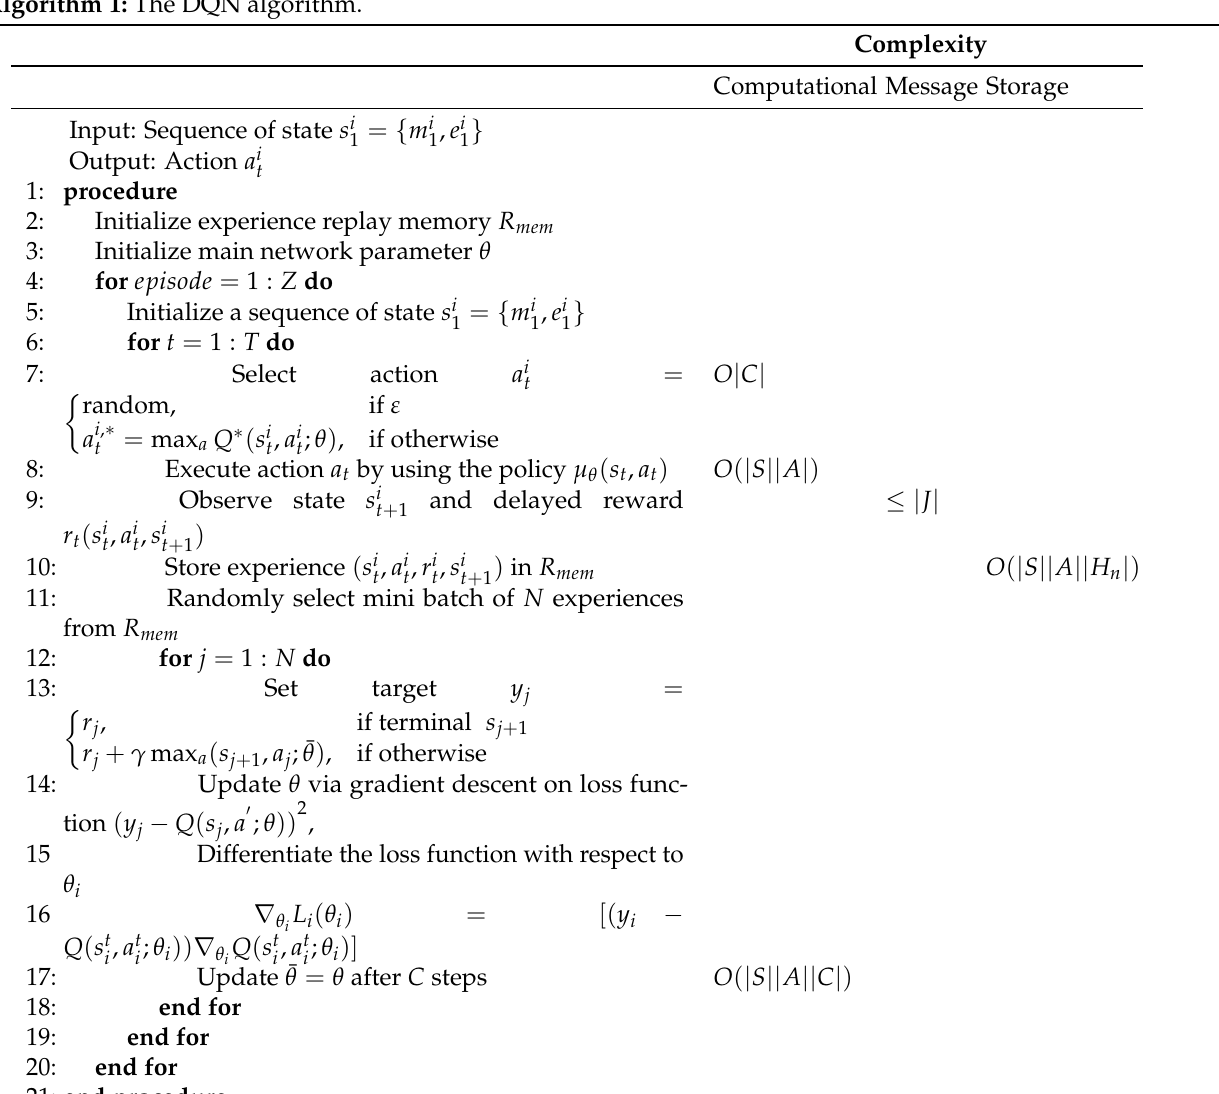
Algorithm 1: The DQN algorithm.